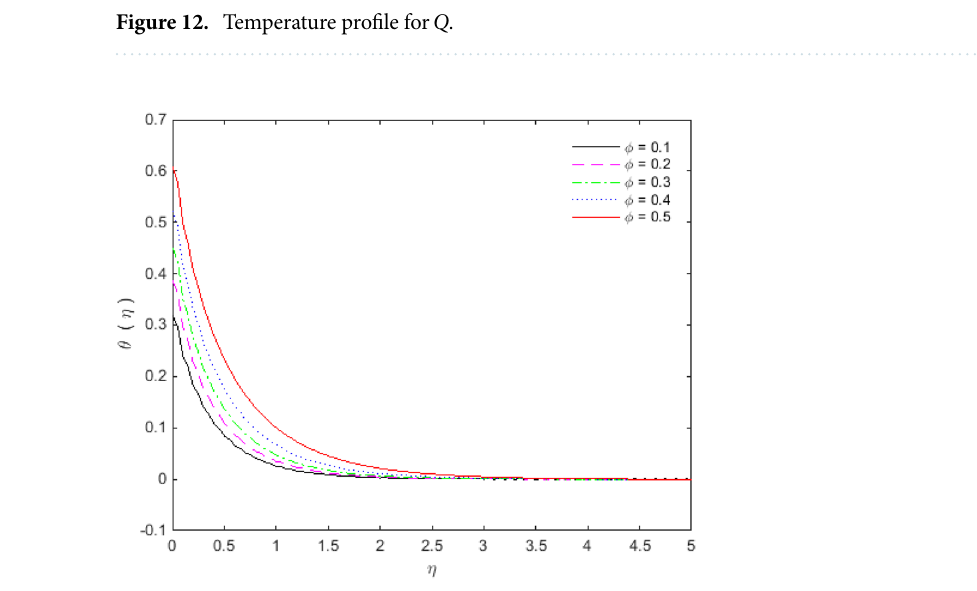
Figure 13. Temperature profile for φ